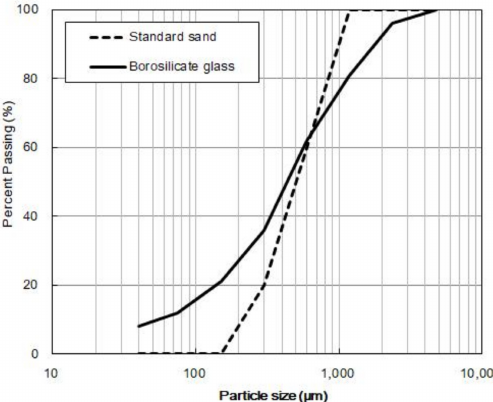
Figure 2. Particle size distributions of standard sand and borosilicate